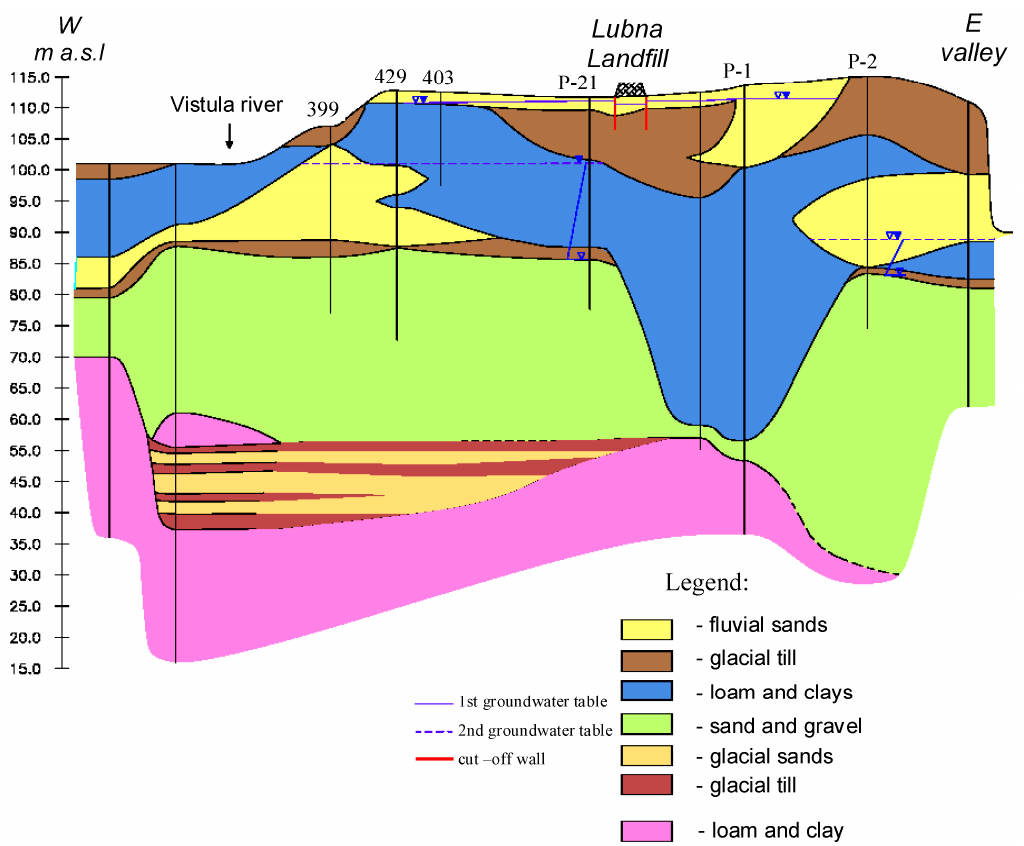
Figure 1. Geological cross-section through the subsoil of the MSW Łubna landfill and its vicinity [15]. Measurements in existing piezometers indicate that the directions of water flow are mainly to the north-west and south-east [15]. These directions are subject to seasonal oscillations that depend on the groundwater level of the first aquifer horizon [19]. Periodically, at high groundwater levels, water stagnates on the surface, forming local ponds. The filtration coefficients for soils in the first aquifer horizon are as follows: for fine and silty sands − k = 3 × 10 − 5 m/s, and for medium and coarse sands − k = 2 × 10 − 4 m/s